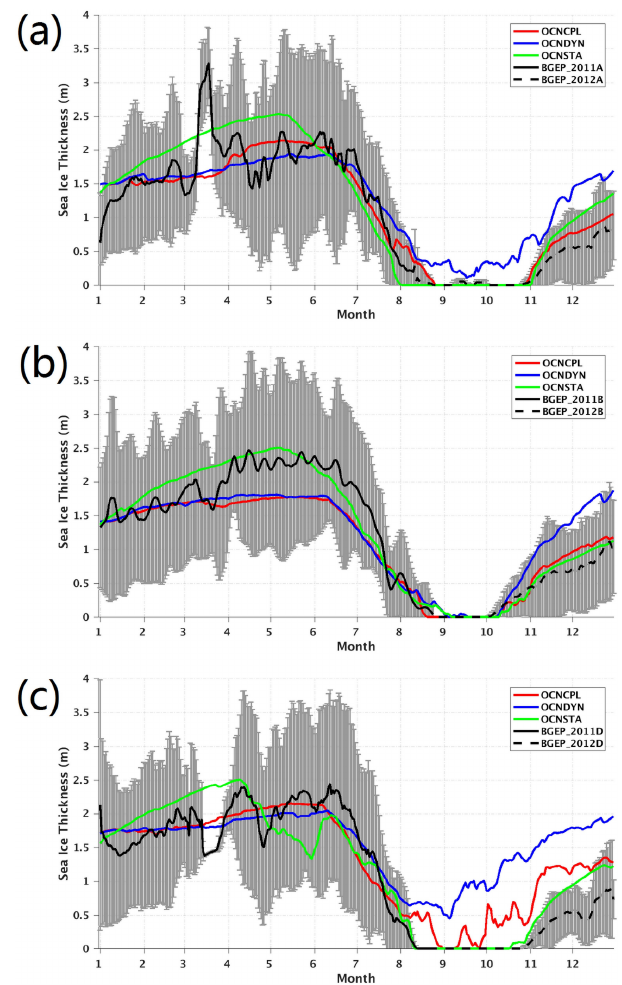
Figure 10. Time series of sea ice thickness at three positions: (a) 75 ◦ N, 150 ◦ W; (b) 78 ◦ N, 150 ◦ W; and (c) 74 ◦ N, 140 ◦ W. The red, blue and green lines denote sea ice thickness of the OCNCPL run, the OCNDYN run and the OCNSTA run, respectively. The black solid and dashed lines denote sea ice thickness observations of the BGEP ULSs, which were deployed in the summers of 2011 and 2012. The black lines of the BGEP ULS observations have been smoothed with the gray bar representing the observational uncer- tainties. BGEP: Beaufort Gyre Exploration Project; ULS: upward- looking